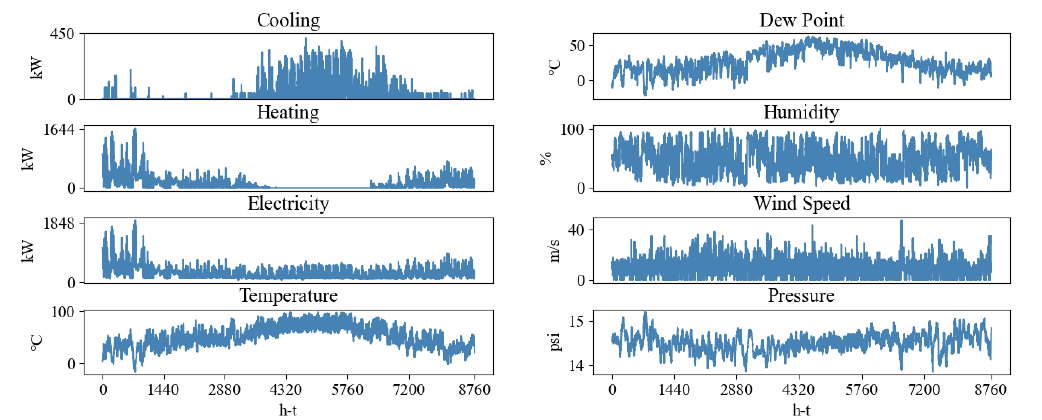
Figure 1. IES year-round actual